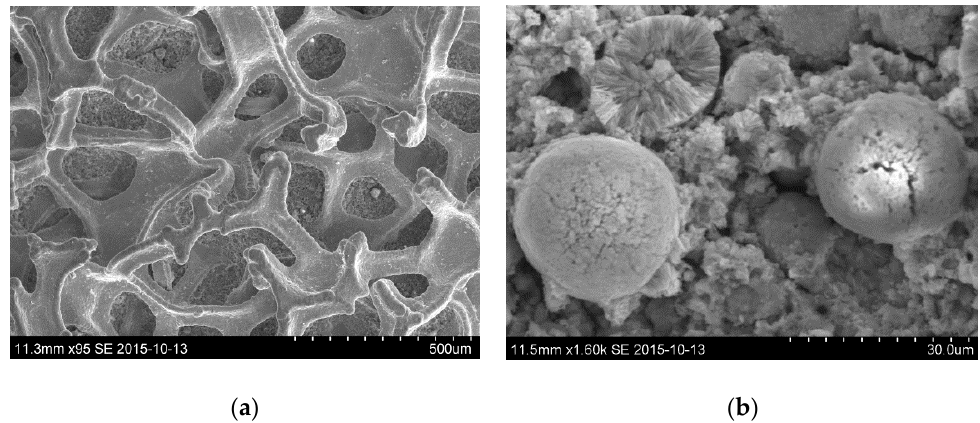
Figure 1. SEM images of cathode material; ( a ) supporting mesh, ( b ) nickel hydroxide